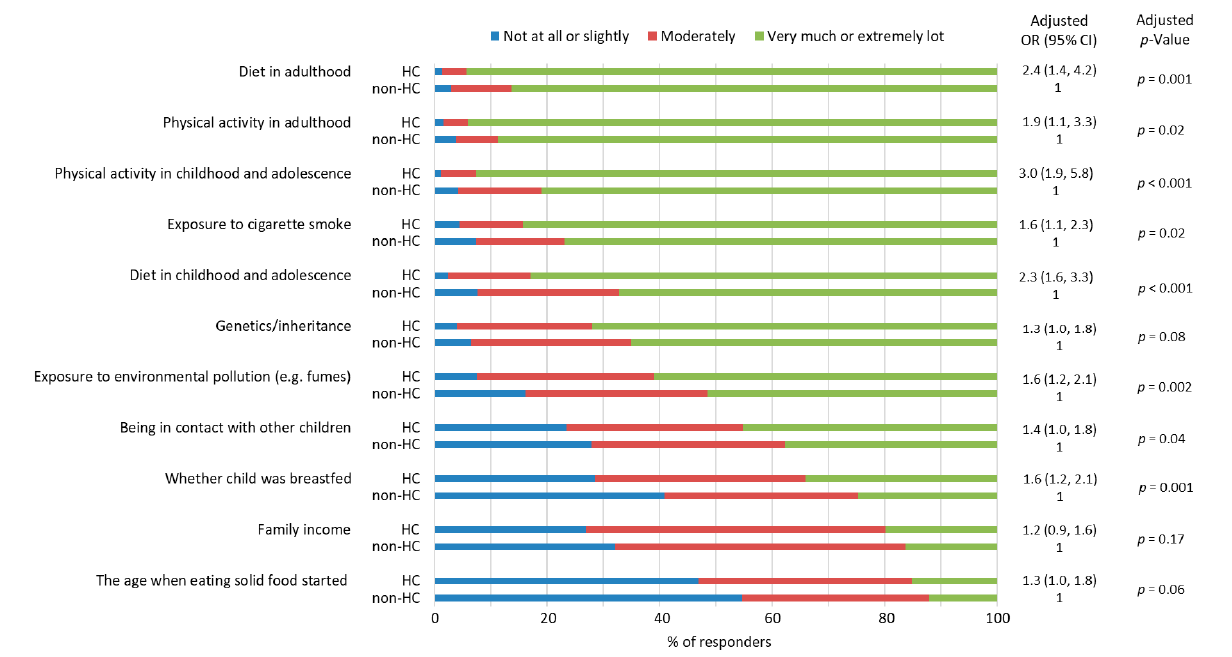
Figure 3. Health-conscious (HC) and non-health-conscious (non-HC) parents ´ views on the extent to which different factors affect the health of the child in adulthood. Associations between the parents’ views and parental health consciousness were examined by ordinal logistic regression analyses after adjustment for the parents’ gender, education, and whether the parent had a degree in a field of health or nutrition. Missing data n = 31–43 depending on the question. OR = odds ratio, CI = confidence interval.